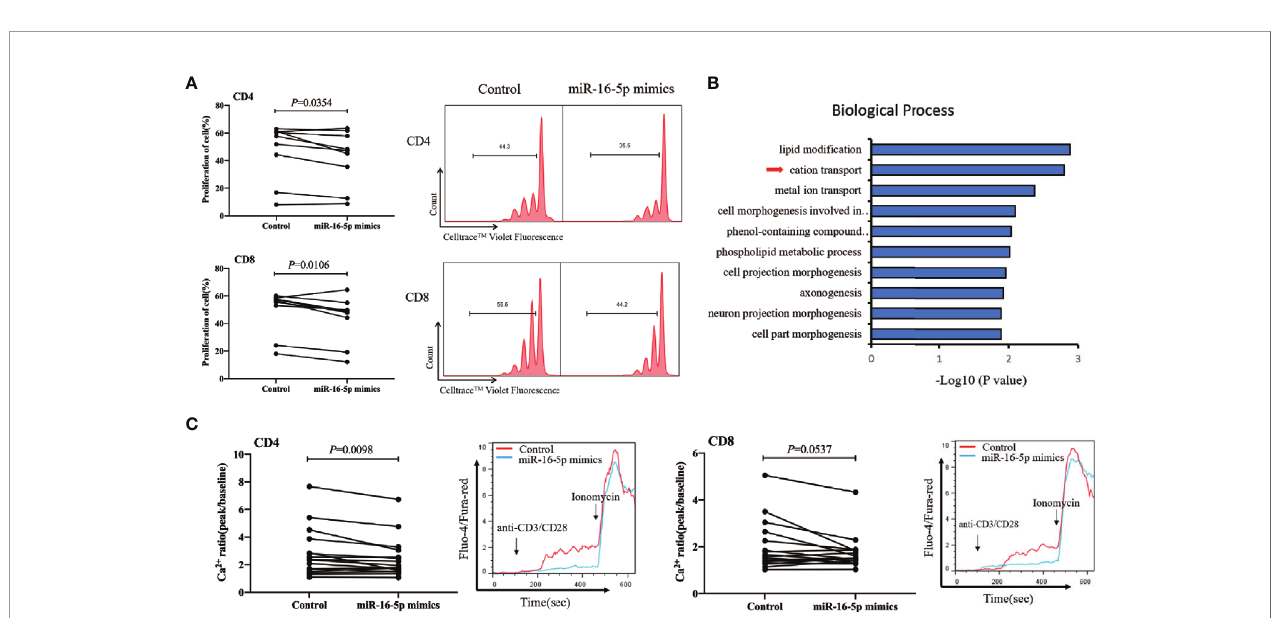
FIGURE 5 | miR-16-5p overexpression suppresses T cell proliferation and Ca 2+ fl ux. (A) T cells from people with human immunode fi ciency virus (HIV) infection (n = 9) after antiretroviral therapy (ART) were transfected with miR-16-5p mimic or control. Representative histogram (right) showing proliferation of CD4 + T cell (top) and CD8 + T cell (bottom), measured using Cell Trace ™ Violet. (B) Analysis of differentially expressed genes (using DAVID) between miR-16-5p mimic and control based on the transcriptome. (C) Ca 2+ fl ux in CD4 + T cells (left) and CD8 + T cells (right) assessed using fl ow cytometry at baseline and then after the addition of anti-CD3 and anti-CD8 antibodies, presented as the ratio of fl uorescence at the peak to fl uorescence at baseline (n = 16).